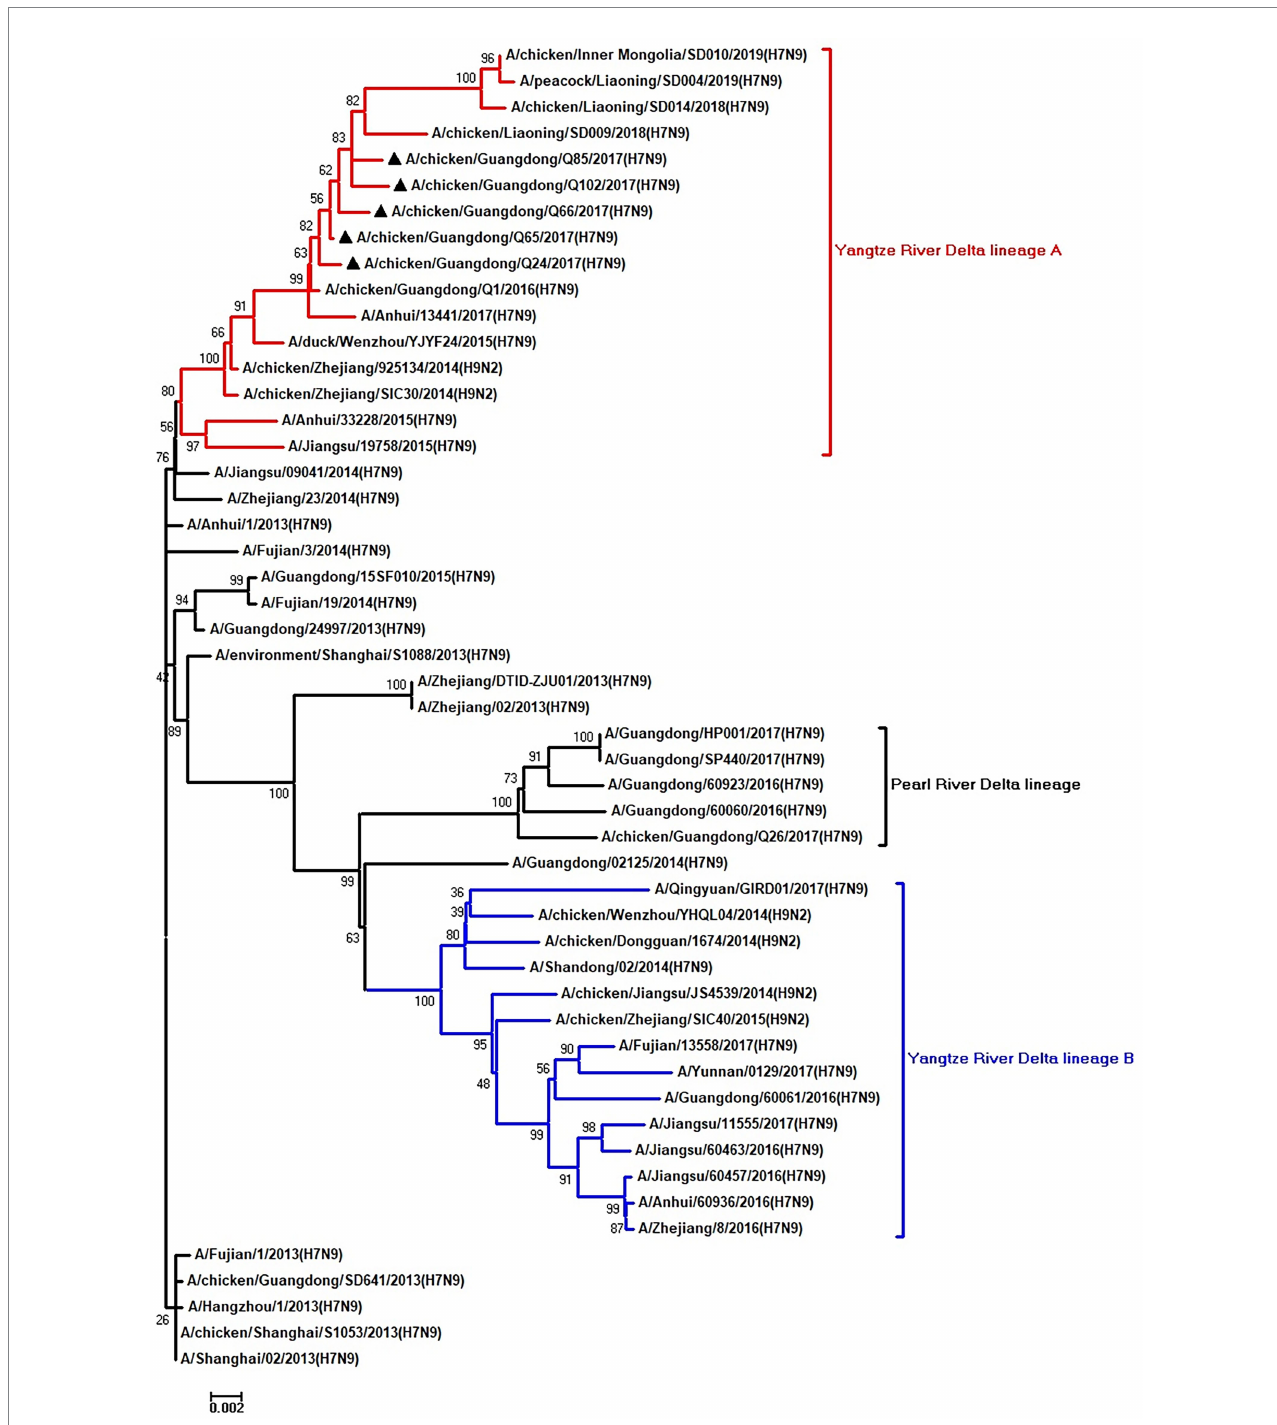
FIGURE 4 Phylogenetic analysis of PA. The tree was constructed by using the neighbor joining method with the Maximum Composite Likelihood model and MEGA version 5.2 (www.megasoftware.net/) with 1,000 bootstrap replicates based on the following sequences: PA: nt 25–2,175. Except our five isolates, other virus sequences were downloaded from GenBank. Triangles indicate the viruses characterized in this study. The scale bar indicates the branch length and corresponds to 0.002 estimated amino acid substitutions per